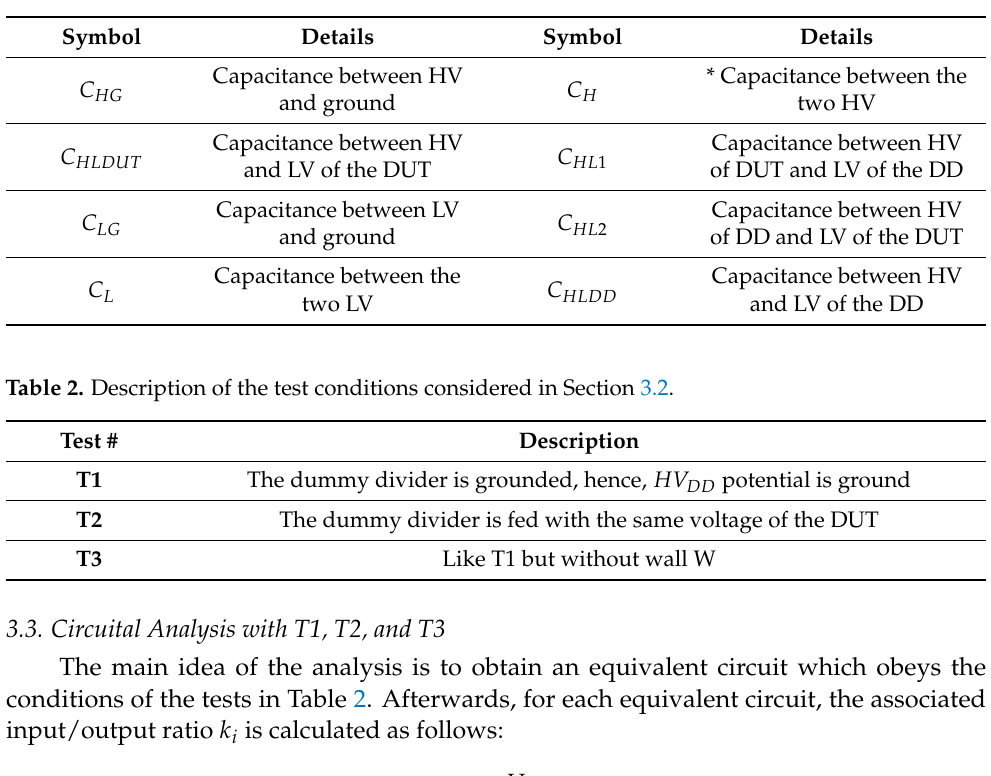
Figure 3. The equivalent circuit of the setup in Figure 2 including the stray capacitances (SCs). Table 1. List of SCs and their meaning.